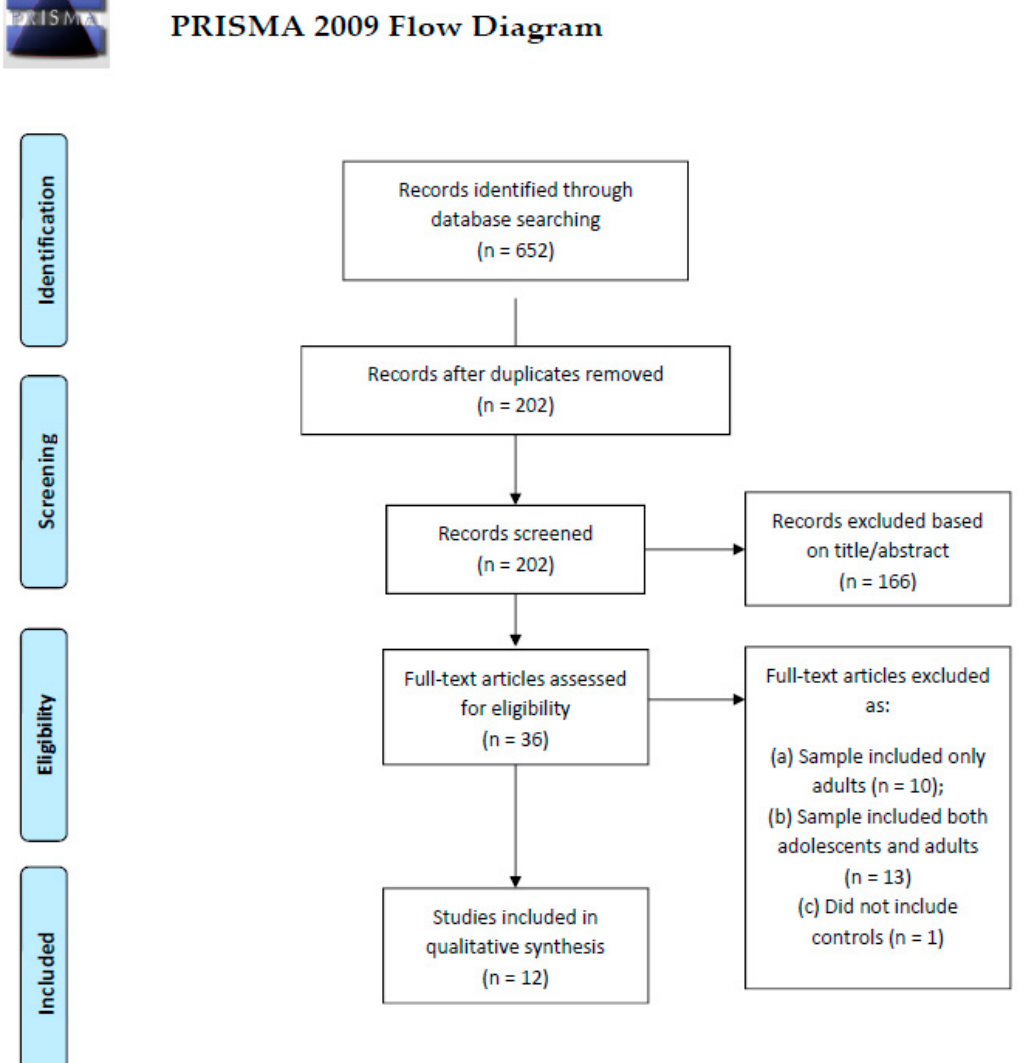
Figure 2. Flow-chart of study selection. The flow-chart reports the steps performed for the selection of studies to be included in the current review, according to PRISMA guidelines. Studies involving mixed samples of adolescents and young adults were only considered if they treated them as different samples, or verified the findings separately in the two age groups.